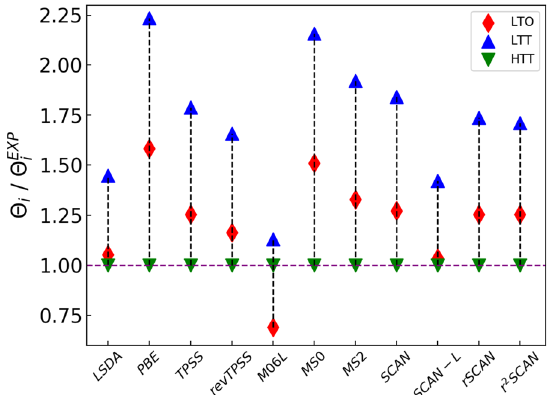
Fig. 4 Theoretically predicted values of octahedra tilt angle using various density functional approximations for LCO. The LSDA and PBE values are taken from ref. 22 The octahedra tilt values for LTO, LTT, and HTT are divided by corresponding experimental values.